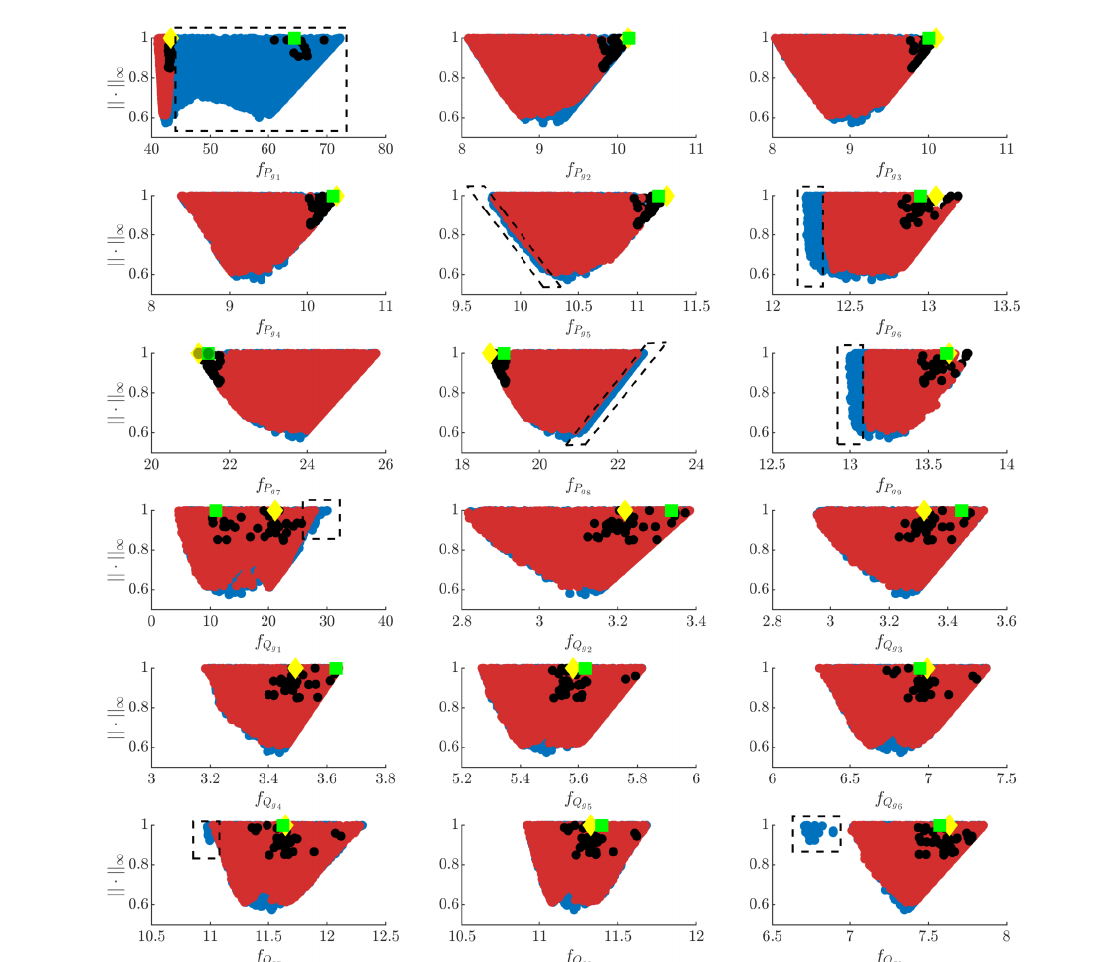
Figure 9. Comparison of Pareto fronts by means of LDs with the ∞ -norm. Blue and red dots correspond ∗ C 1 6 p ) ) and 2 ( f ( X ∗ C 2 4 p ) ), respectively. Dashed lines delimit regions to design concepts 1 ( f ( X p p